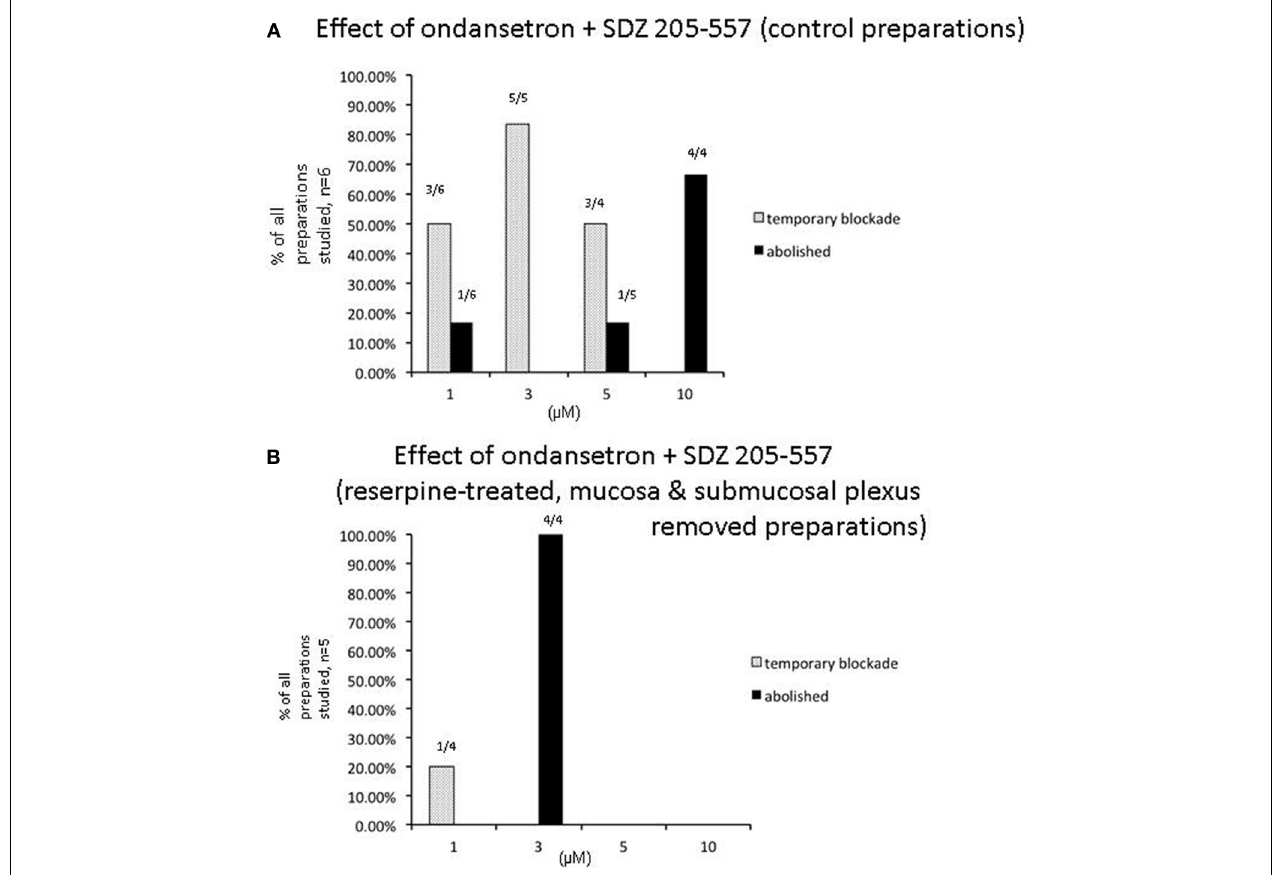
FIGURE 8 | Sensitivity of individual experiments to the combined effects of receptor antagonists to 5-HT3 and 5-HT4 receptors. (A) Shows control data of the proportion of individual colonic preparations that showed repeated temporary blockade of repetitive peristaltic contractions with increasing concentrations of SDZ-205–557 and ondansetron. The table shows responses of 6 control animals to consecutive application of increasing concentrations of ondansetron and ondansetron (1–10 µ M) and responses to 4 preparations treated with reserpine and also with mucosa and submucosal plexus removed. Interestingly, in reserpinized preparations, with mucosa and